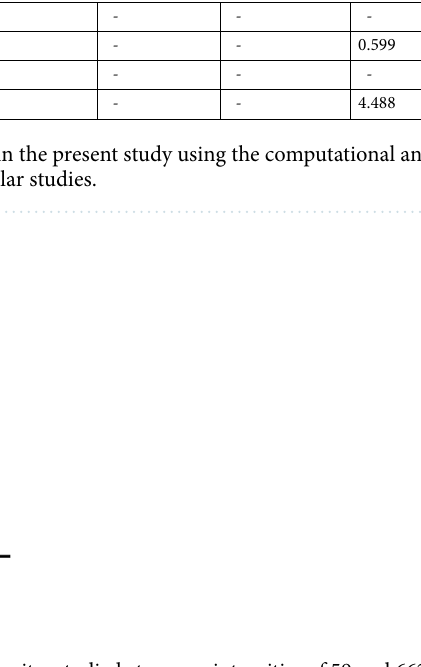
Figure 8. The measured HVL values for the five composites studied at energy intensities of 59 and 662